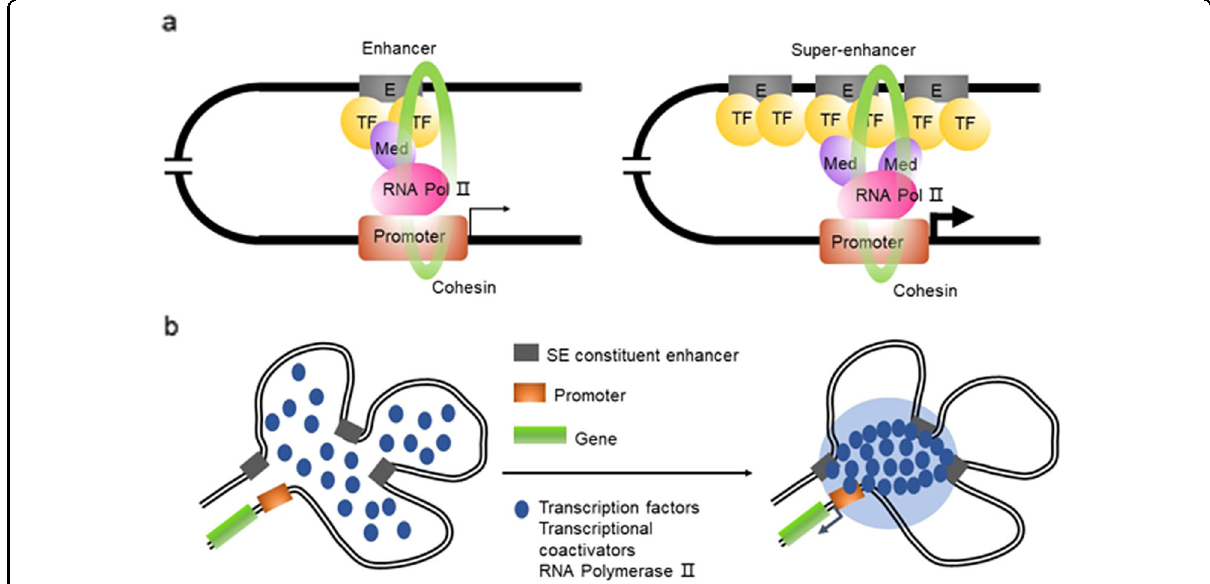
Fig. 1 Schematic illustration of SE function and activation. a Enhancers and SEs are occupied by a high density of transcriptional regulators, including transcription factors, coactivators, and the RNA pol II complex. b A phase separation model of SE activation. High-density interactions between transcriptional regulators form phase-separated multimolecular complexes at the SE locus, leading to the transcription of SE-driven